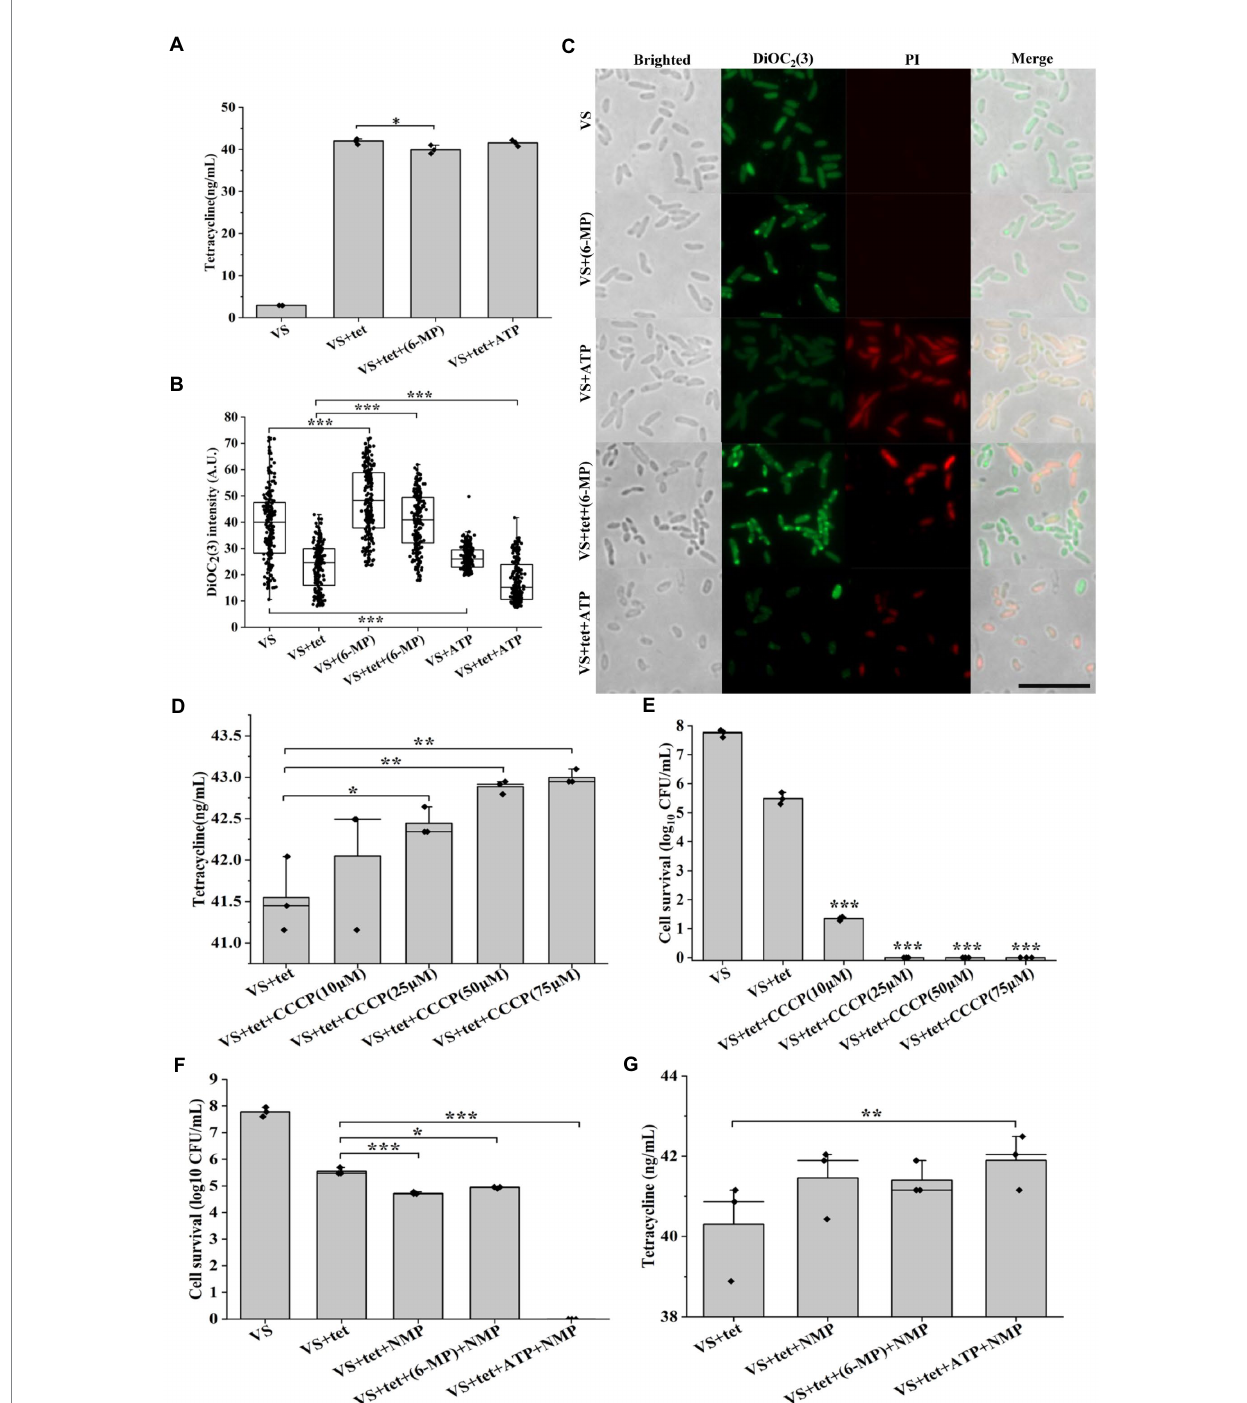
FIGURE 4 Inhibition of purine metabolism reduces intracellular tetracycline accumulation. Intracellular tetracycline concentration (A) and fluorescence intensity of membrane potential (B, C) of cells were assayed in the presence of 6-MP/ATP ( n = 200 for each group). Scale bar, 10 μ M. Intracellular tetracycline concentrations of cells (D) and persister cells formation frequency (E) were further assayed in treated with different concentrations of membrane potential inhibitor CCCP. After inhibition of efflux pump by NMP, persister cells formation frequency (F) and intracellular tetracycline concentration (G) were investigated in 6-MP/ATP exposure conditions. The bars indicated the mean of at least three independent experiments; standard deviation indicated STDEV. (* p value < 0.05; ** p value < 0.01; *** p value < 0.001). The microscopy settings were the same across all the